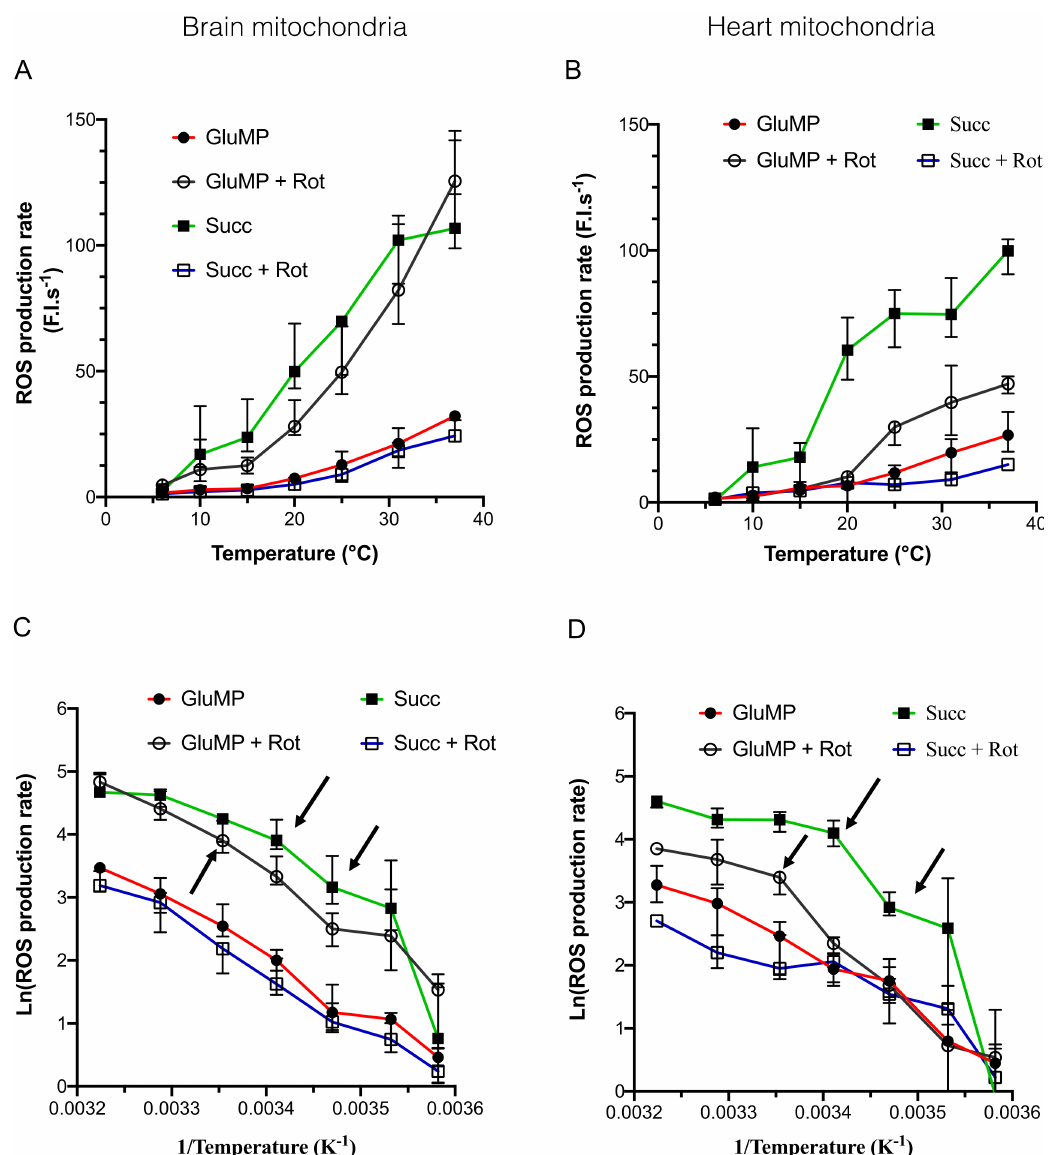
Figure 2. The dependance of mitochondrial ROS production rate on the temperature. ( A ) ROS production rate in brain mitochondria, in arbitrary fluorescence unit/sec, according to temperature (6, 10, 15, 20, 25, 31, and 37 ◦ C). For each temperature, each experiment was performed on the same sample in the same cuvette: GluMP (respectively, succinate) was first added, followed by rotenone. n = 4 to 7 for each temperature. Data are expressed as mean ± IC95%. ( B ) as A for heart mitochondria. ( C , D ) Arrhenius plots of data from ( A , B ) panels, respectively, expressed as % of maximum. Mean ± IC95%. Arrows indicate characteristic inflexion point in the activation